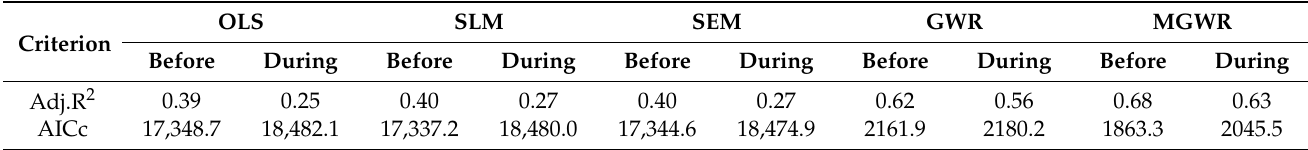
Table 4. Comparison of the goodness of fit measures for global and local models.